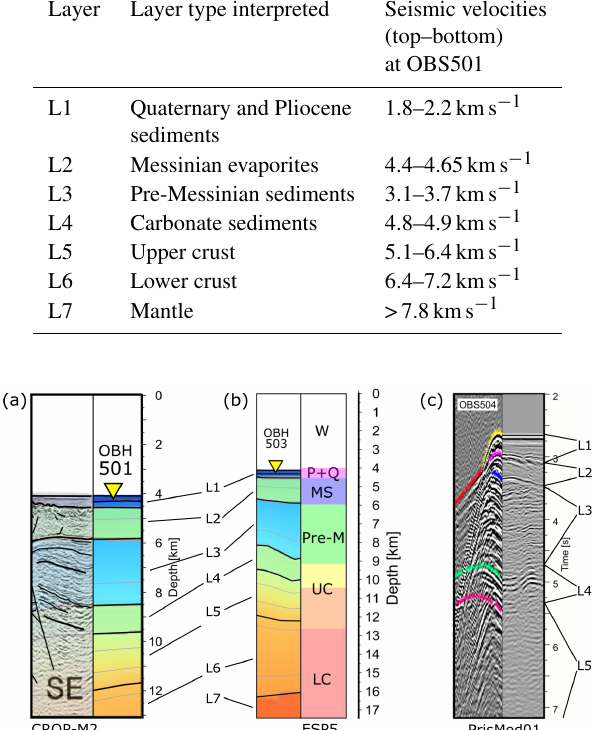
Table 2. Overview of the layers in Figs. 4 and 5 including interpre- tation of the unit and seismic velocities for each layer at OBH501. Layer Layer type interpreted Seismic velocities (top–bottom)